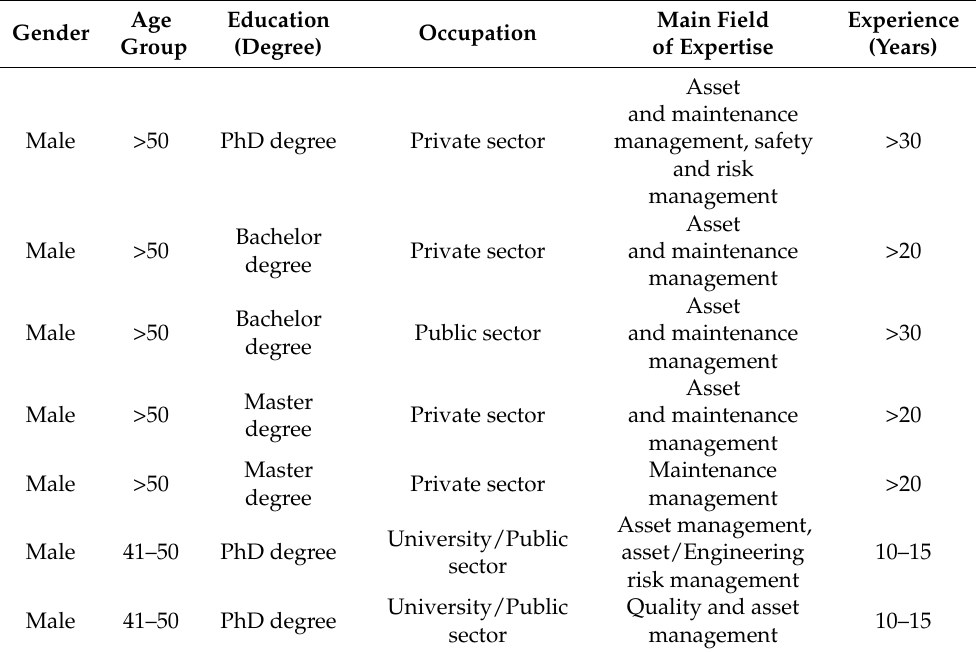
Table A1. Demographic data of evaluators.